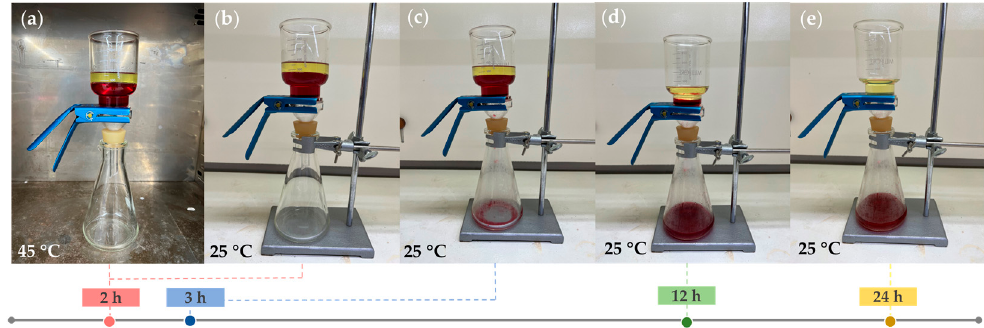
Figure 12. The images of oil - water mixture separation of linear PNIPAm - grafted nylon membrane with grafting yield of 35%; ( a ) the oil and water phases were obstructed above the linear PNIPAm- grafted nylon membrane and ( b ) – ( e ) the water separation process at below LCST of PNIPAm.